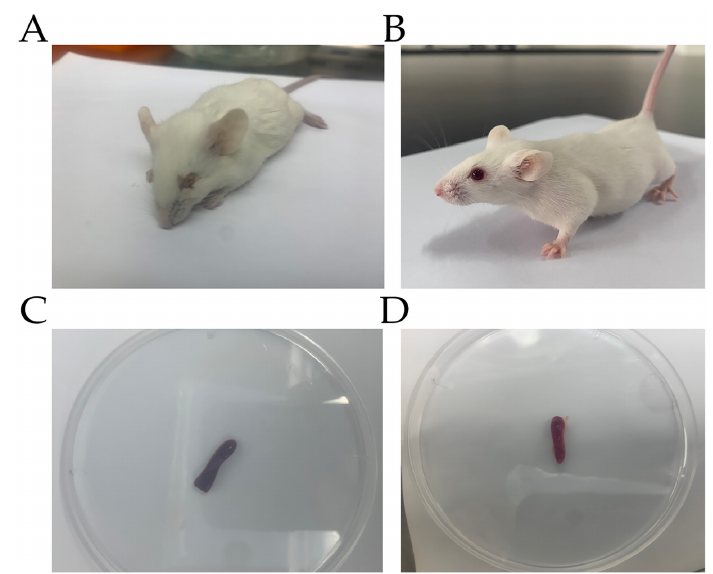
Figure 1. Mice and spleens, respectively, in challenge group ( A , C ) and control group ( B , D ). ( A ) Mouse showed depression and conjunctivitis. ( B ) Control group mice showed no symptoms. ( C ) Mouse spleen turned black, showing hyperemia and swelling. ( D ) Spleen in control group showed no pathological changes.